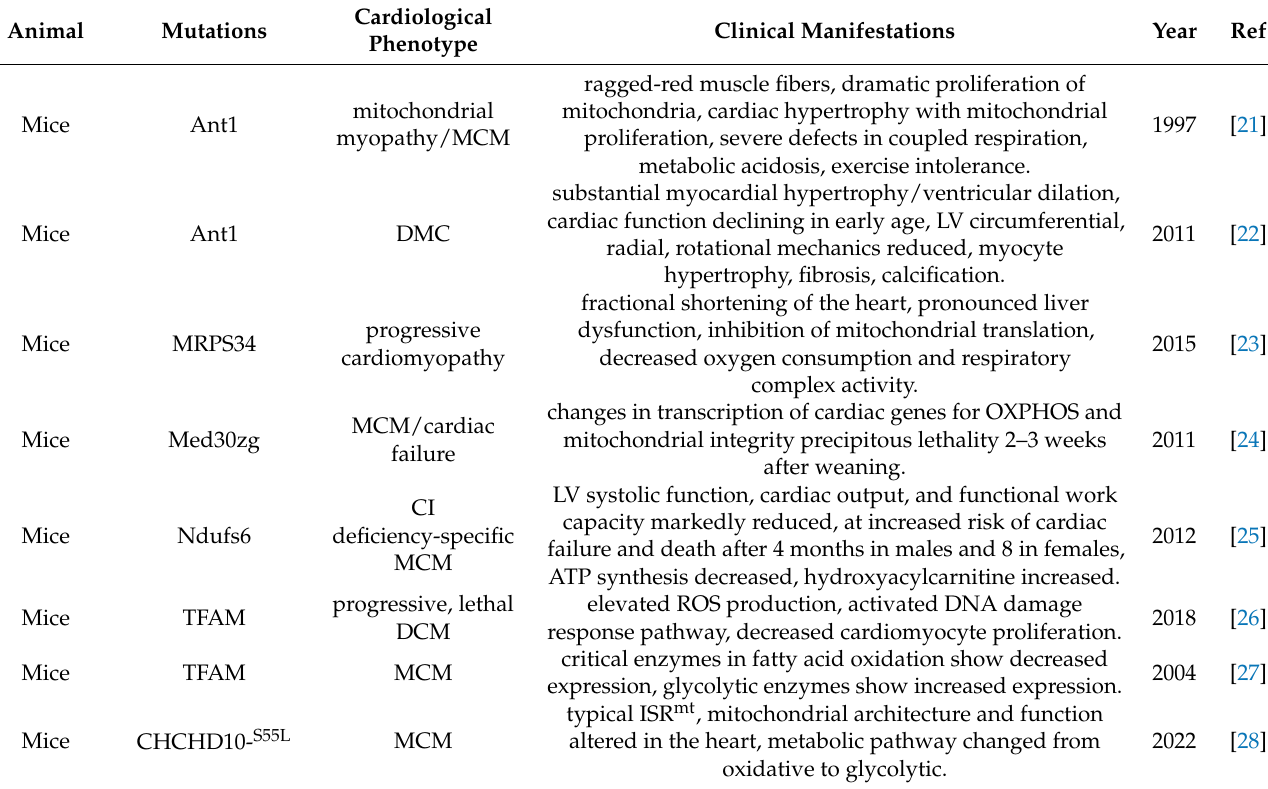
Table 2. List of the current animal models used in